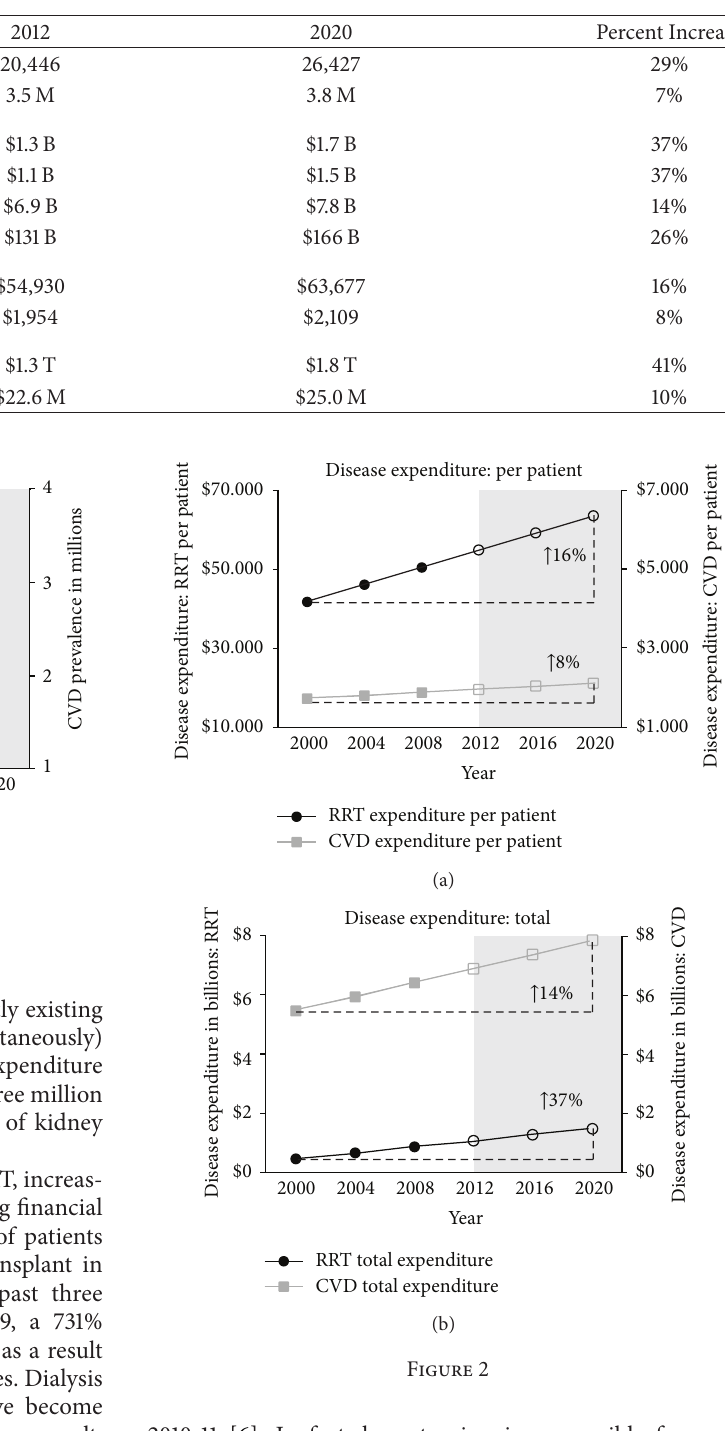
Table 1: Current and projected prevalence rates and expenditure in Australia: